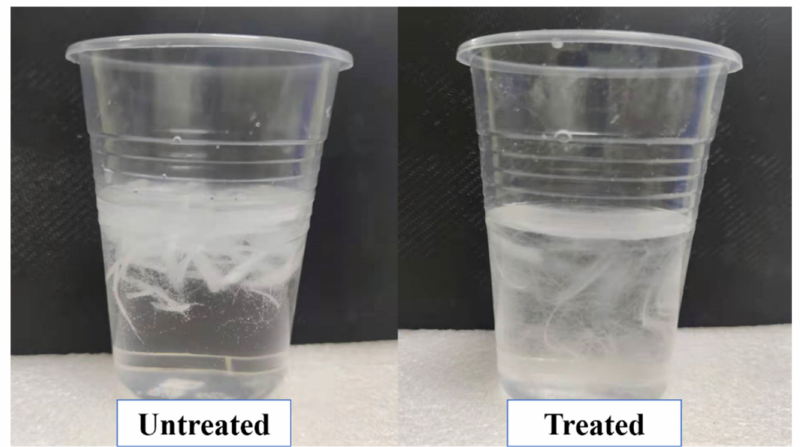
Figure 4. Dispersion of untreated and treated PP fiber in